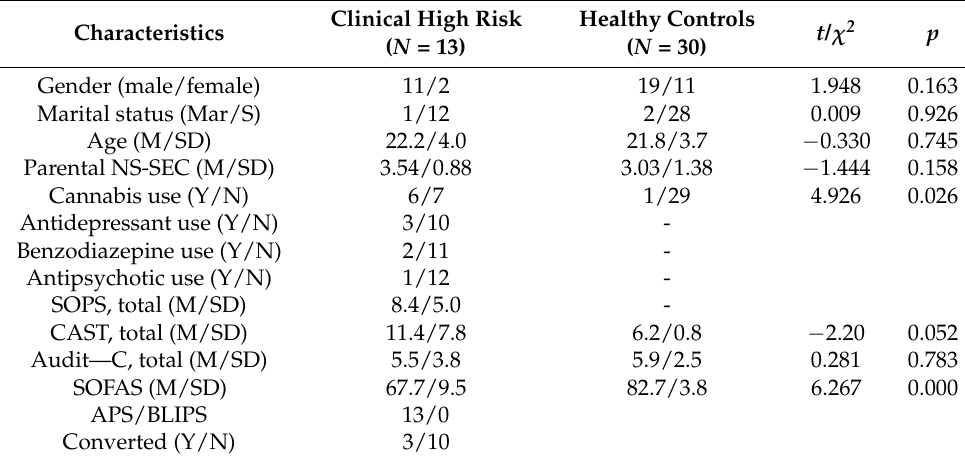
Table 1. Demographics and clinical characteristics.